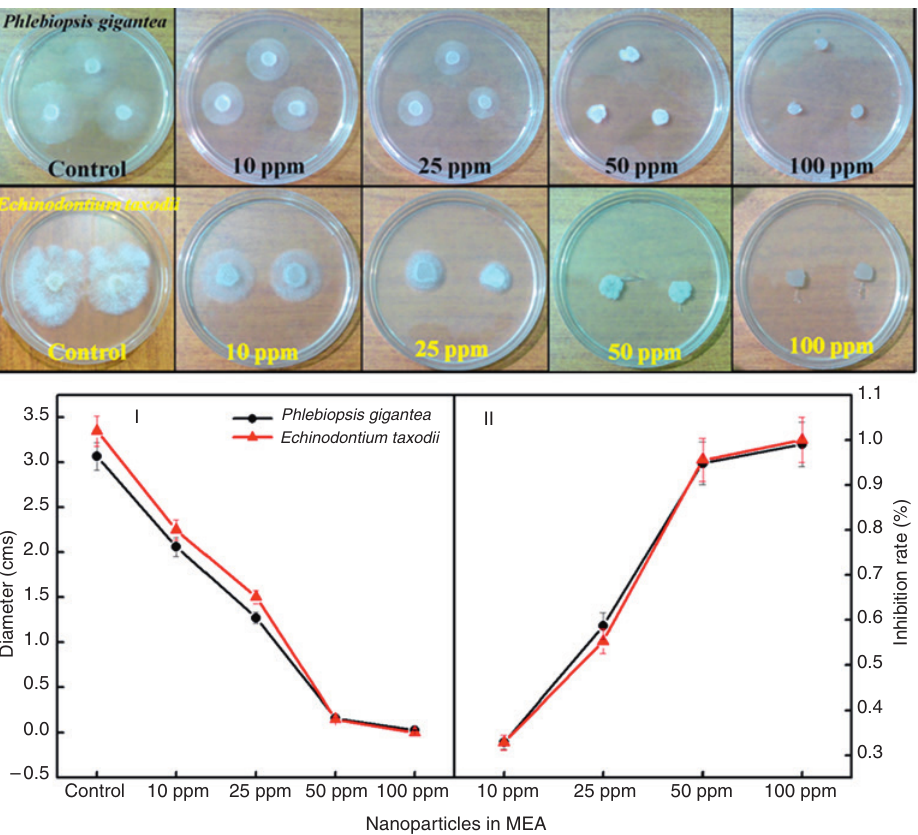
Figure 7: Fungal growth response of Phlebiopsis gigantean (black labelled) and Echinodontium taxodii (yellow labelled) inoculated on media containing different concentrations of silver nanoparticles (AgNPs) and (I) fungal growth diameter and (II) percentage inhibition of fungal growth (right) with increasing AgNPs concentration.